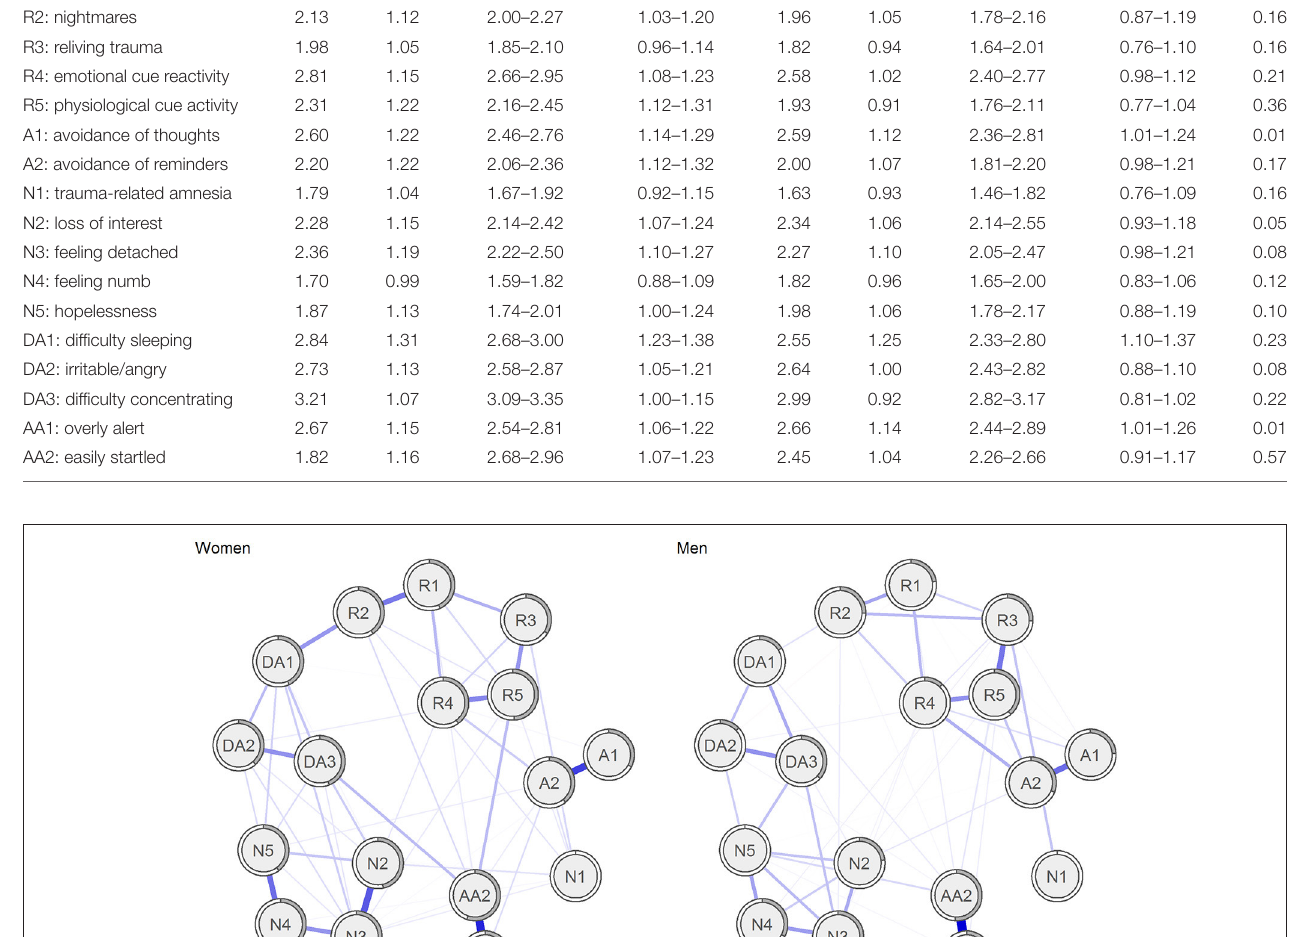
gender differences. As in most other network studies, we found